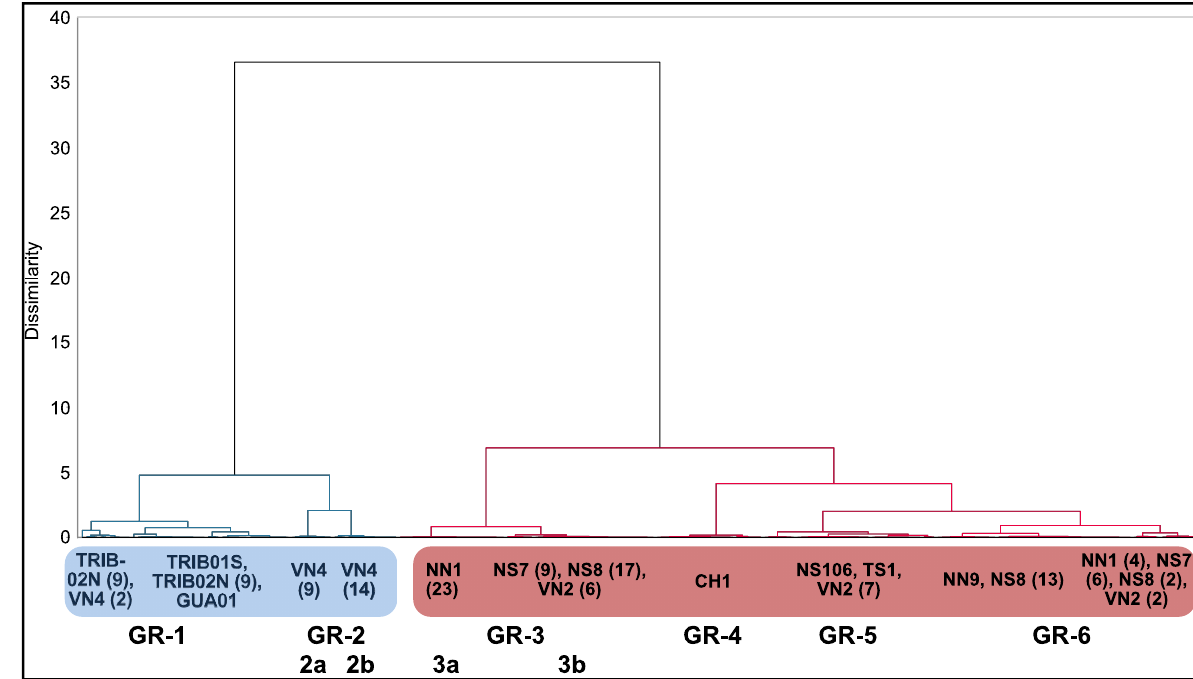
Fig 15. HCA on the SI trace element composition (Xij) of all samples. The two main branches with the highest dissimilarity are highlighted in blue and red. For samples represented in different branches, the number of SI in each branch is indicated in brackets. Clusters were determined by the elbow